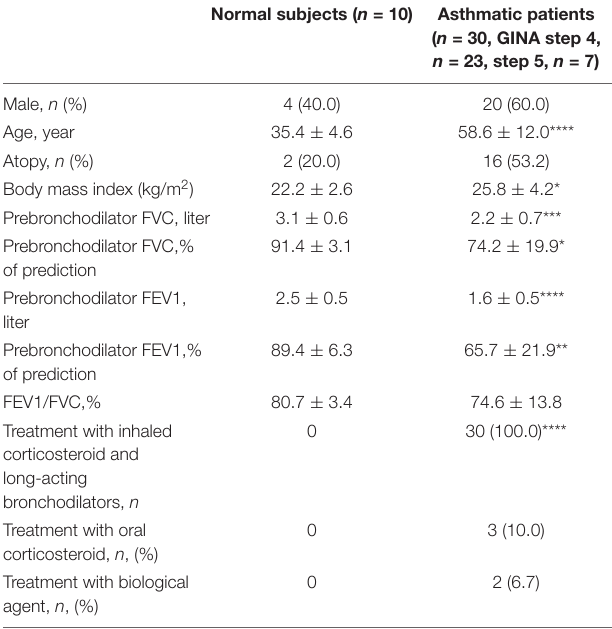
TABLE 1 | Characteristics of recruited